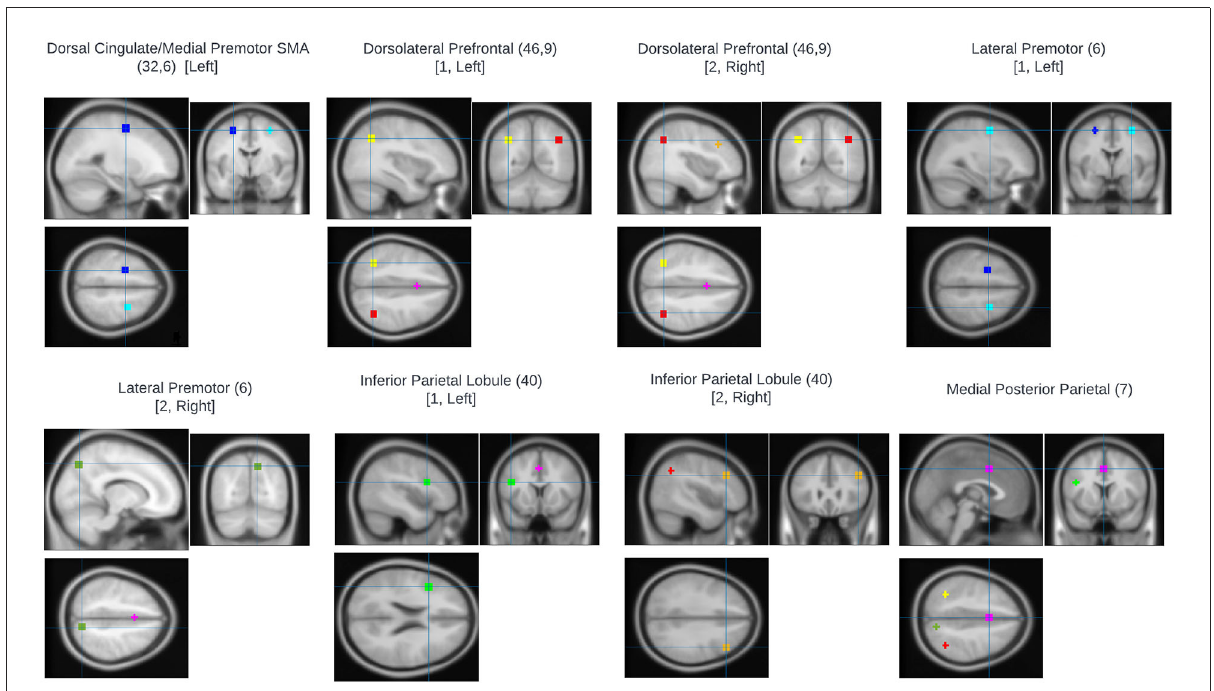
FIGURE1 Regions of interest used for fMRI analysis. All were based on the prior meta-analysis of the n-back carried by Owen et al. (23). Sphere centrum coordinates were selected for each meta-analytic peak associated with an Activation Likelihood Estimate (ALE) score ≥ 0.04.